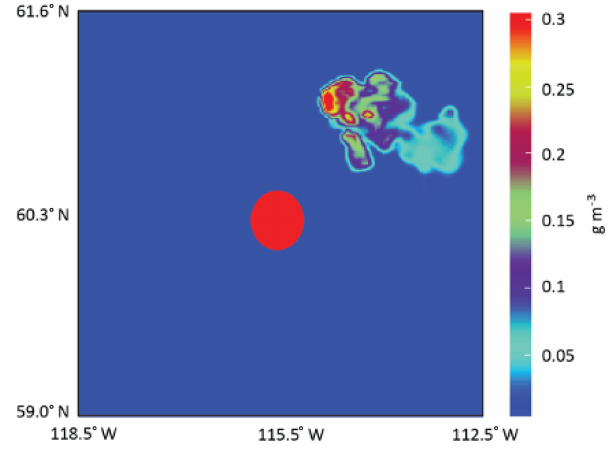
Figure 2. The simulated fire spot (red circle) and the field of cloud- ice mass density (cirrus cloud) at the top of the simulated pyroCb when it is about to enter its mature